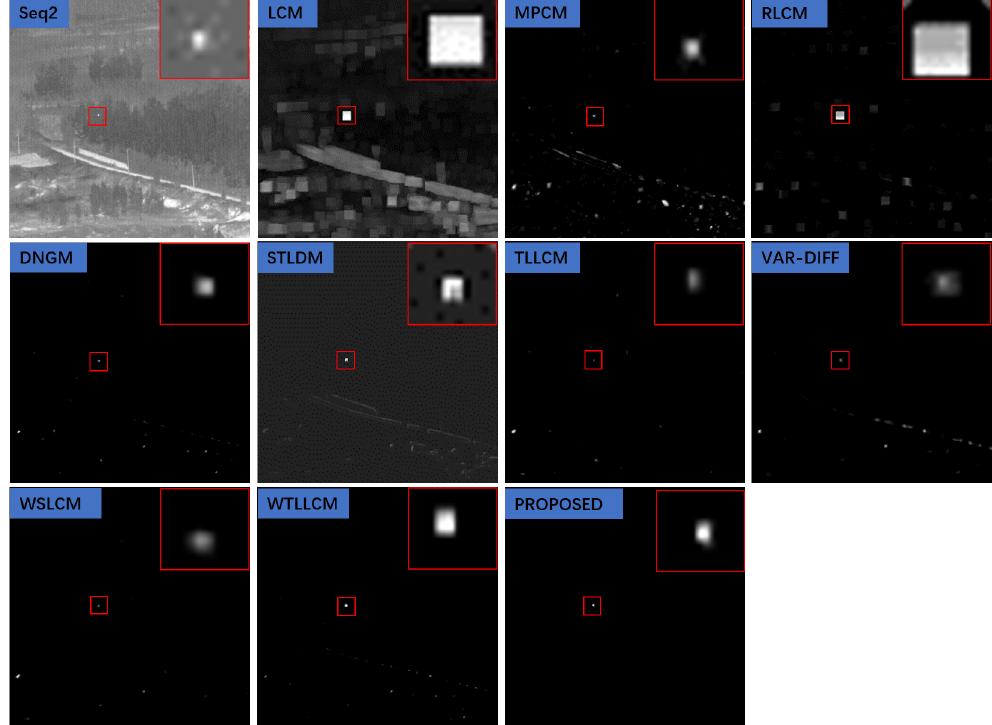
Figure 17. Detection results of one frame in data2. The first sub-image is the original image, and the rest are the detection results of each algorithm.